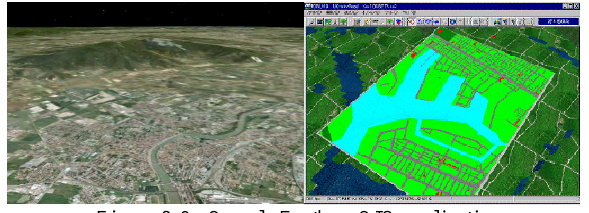
Figure 8-9. Google Earth + GIS application